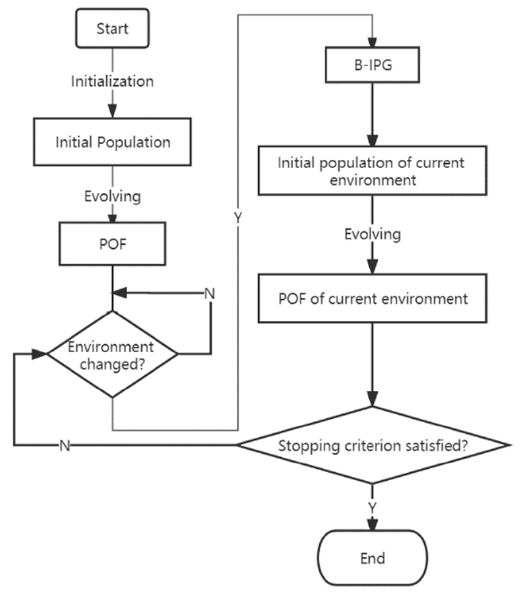
Figure 4. Logic flow chart for Figure 4 . Logic flow chart for B-DMOEA. Algorithm 1 B-DMOEA